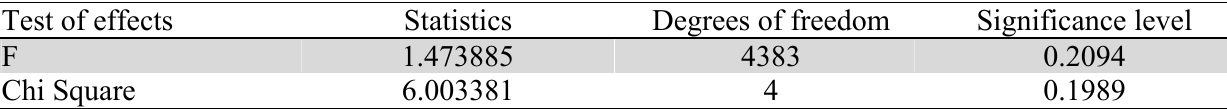
Chow test results Time fixed effects test